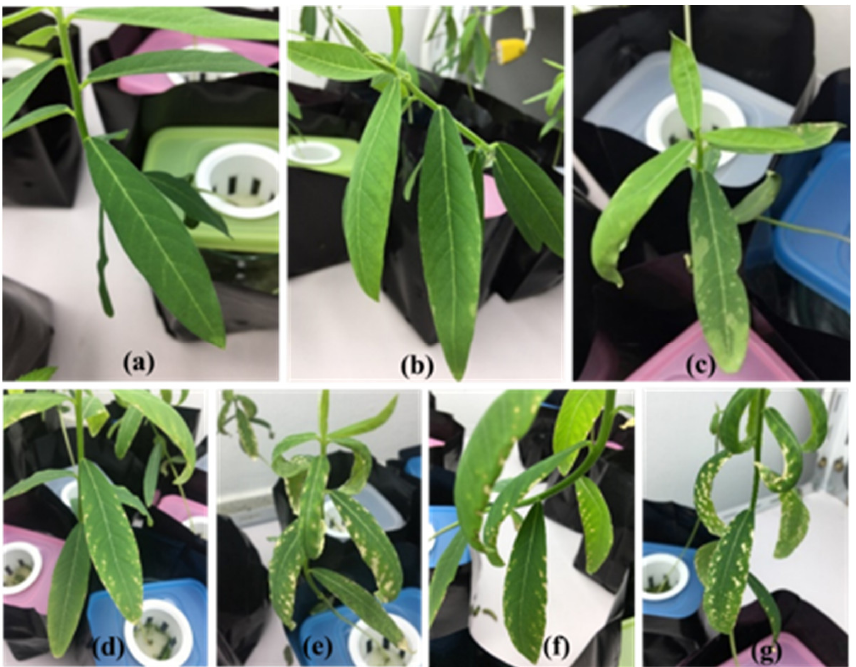
Figure 1. Toxicity in sunn hemp after 4 days of cultivation for carbaryl treatments at 0 mg L − 1 ( a ), 5 mg L − 1 ( b ), 10 mg L − 1 ( c ), after 8 days of cultivation for carbaryl at 5 mg L − 1 ( d ) and 10 mg L − 1 ( e ), after 12 days of cultivation for carbaryl at 5 mg L − 1 ( f ), and 10 mg L − 1 ( g ).